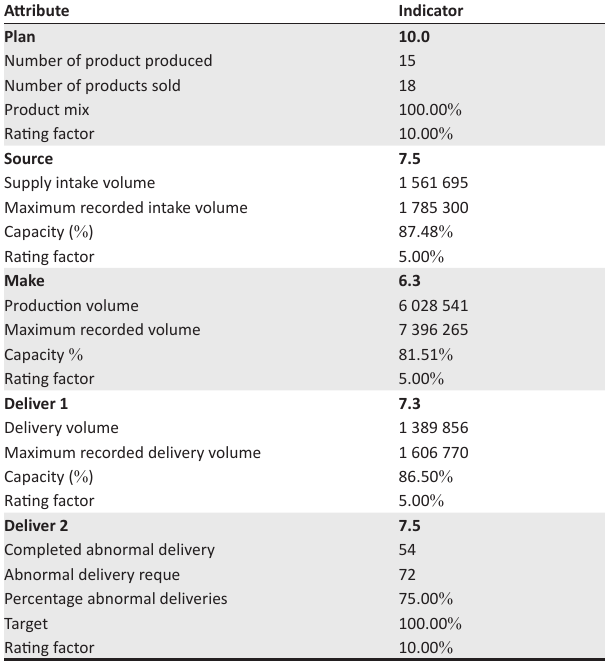
TABLE 20: Developed model: Agility leg. Attribute Indicator